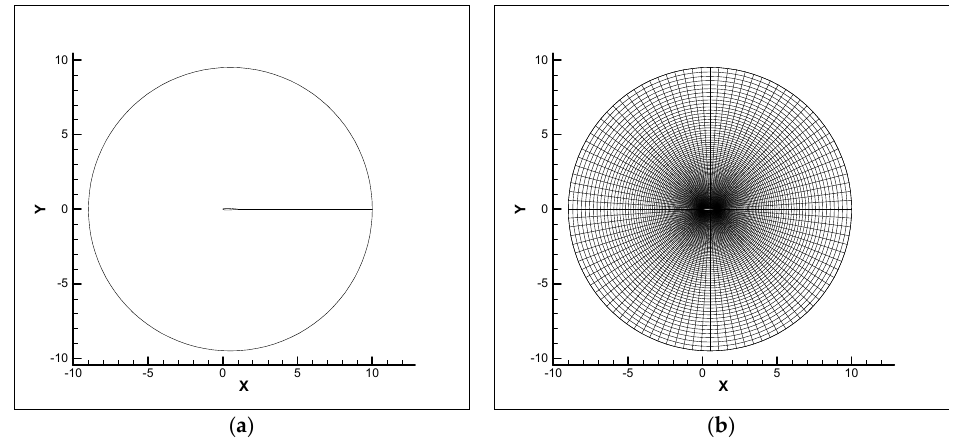
Figure 2. The physical domain before and after meshing. ( a ) Physical domain before meshing. ( b ) Physical domain after meshing. Fluids 2019 , 4 , x